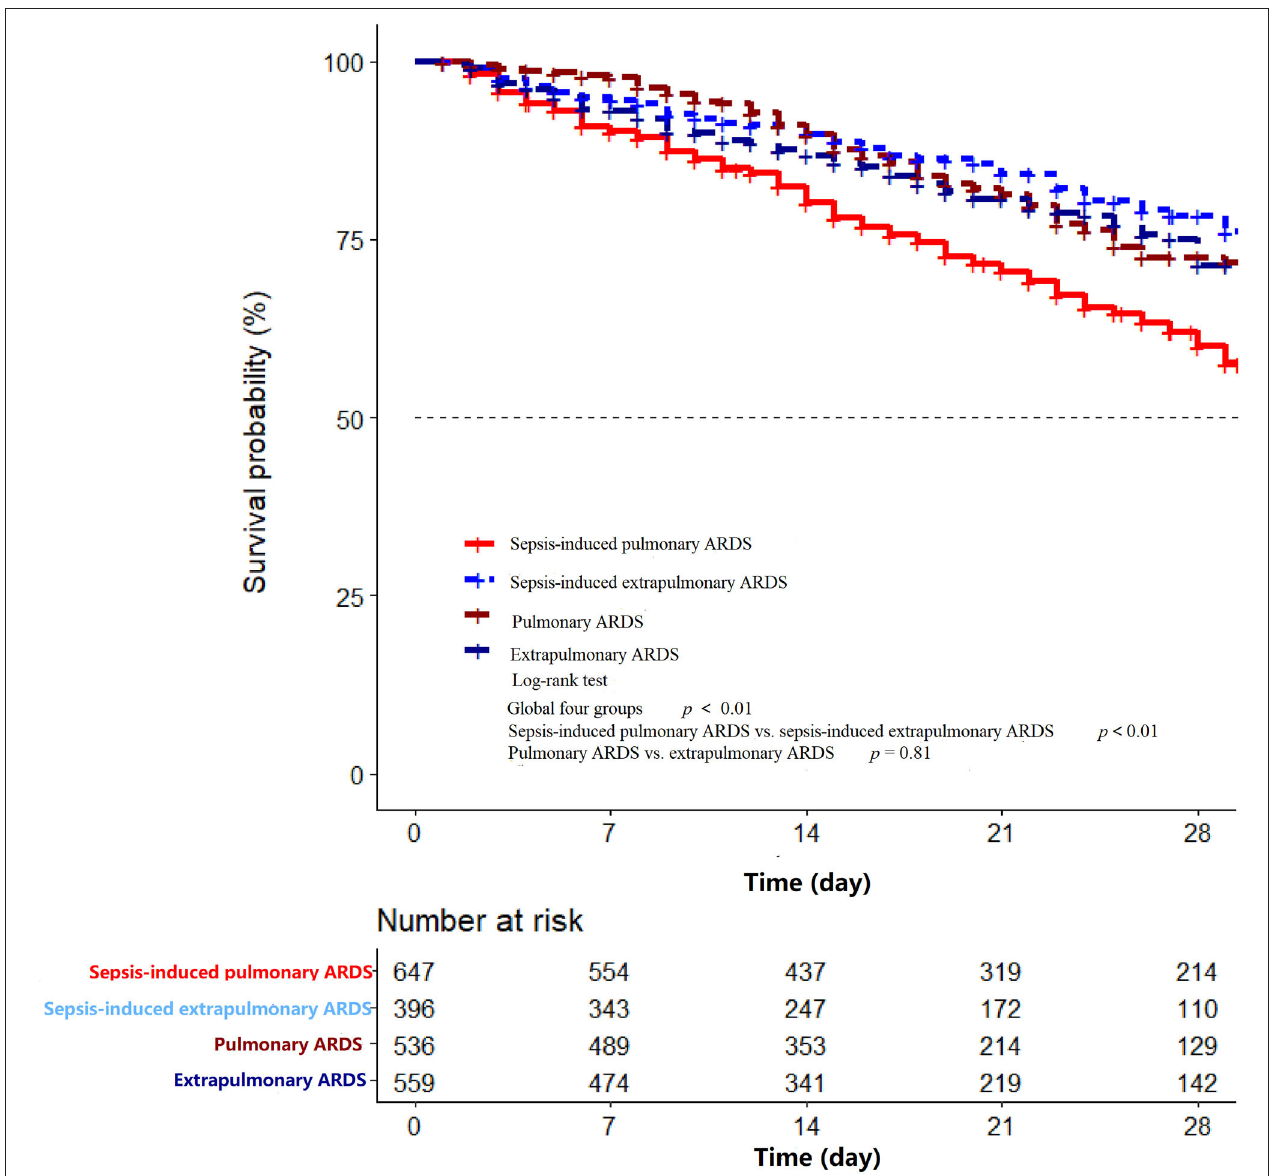
FIGURE 2 | The Kaplan–Meier curve of hospital mortality among sepsis-induced pulmonary ARDS, sepsis-induced extrapulmonary ARDS, pulmonary ARDS, and extrapulmonary ARDS groups in the first 28 days after ICU admission. In the global log-rank test p < 0.01. The log-rank test of sepsis-induced pulmonary ARDS vs. sepsis-induced extrapulmonary ARDS was p < 0.01; for pulmonary ARDS vs. extrapulmonary ARDS p = 0.81.